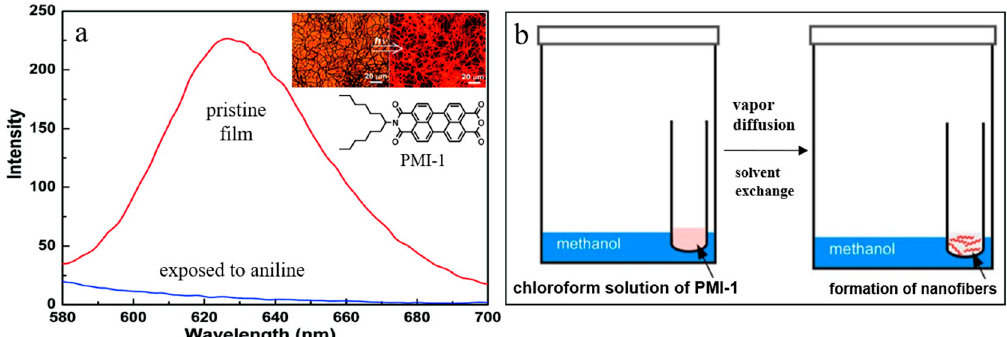
Figure 1. ( a ) Fluorescence spectra of PMI-1 nanofibril film before (red) and after (blue) exposure to the saturated vapor of aniline (880 ppm) for 10 s. Inset shows bright field and fluorescence optical microscopy image of the film; ( b ) A diagram showing the procedure of fabrication of the nanofibers via slow solvent vapor transfer [21].